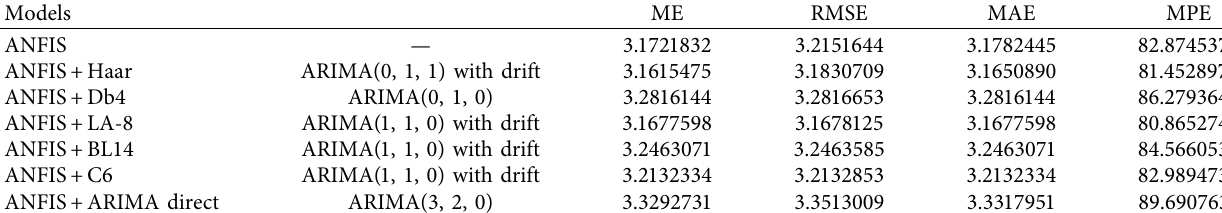
Table 6: The WT function of output variable for 20% dataset.